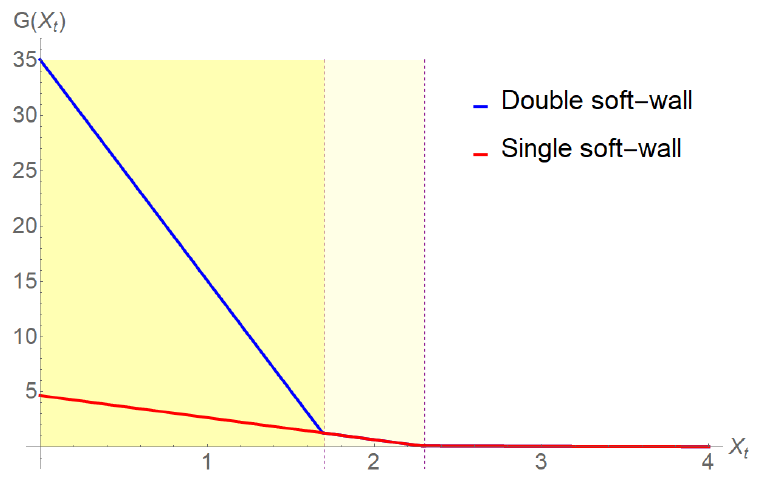
Figure 2. Single (21) and double “increase–increase” (22) force G profiles for k 1 = 0.001, k 2 = 2, k 3 = 20, a 1 = 2.3, a 2 =